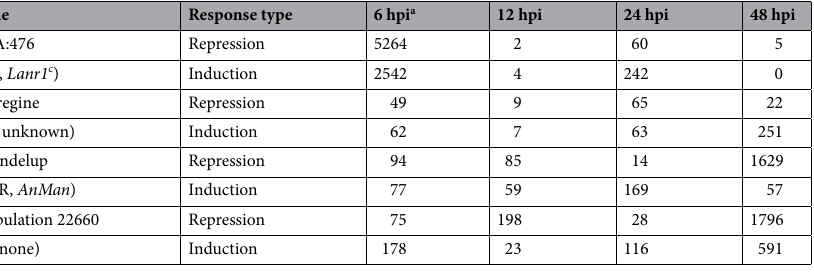
Table 1. Number of genes with significantly altered expression during response of narrow-leafed lupin lines to Colletotrichum lupini inoculation (strain Col-08, obtained in 1999 from the lupin field in Wierzenica, Poland). a Hours post inoculation. b Level of resistance to anthracnose (R, resistant; MR, moderately resistant; S, susceptible). c Allele conferring resistance to anthracnose 25,26